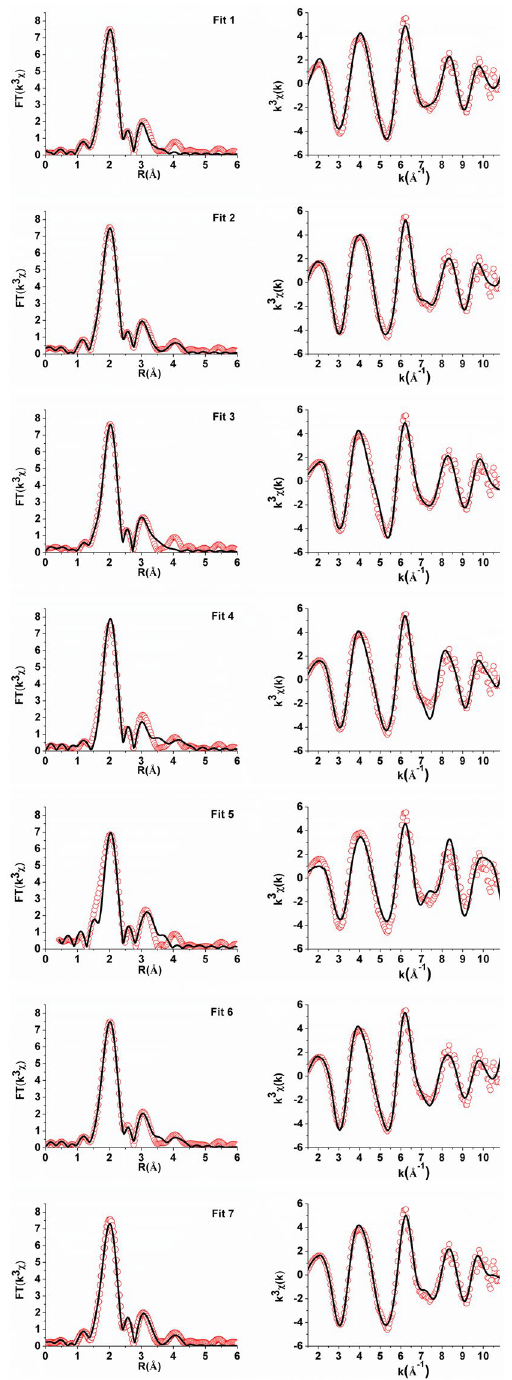
Figure 4. Left: Phase shift corrected Fourier transforms of Fe EXAFS (red circles) and the corresponding best fits (black solid lines); Right: Fe EXAFS (red circles) and the corresponding best fits (black solid lines) of purified